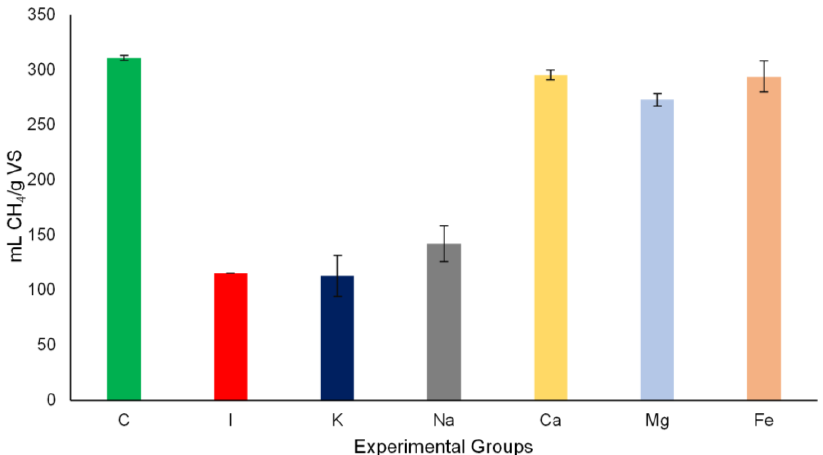
Figure 2. Methane yield (mL CH 4 /g VS) of the positive control (C), inhibition control (I) and salt addition controls; with calcium (Ca), magnesium (Mg), iron (Fe), sodium (Na) and potassium (K). Yields were calculated at the end of the anaerobic degradation tests (14 days). (Error bars show the standard deviation between measurements, n = 2).